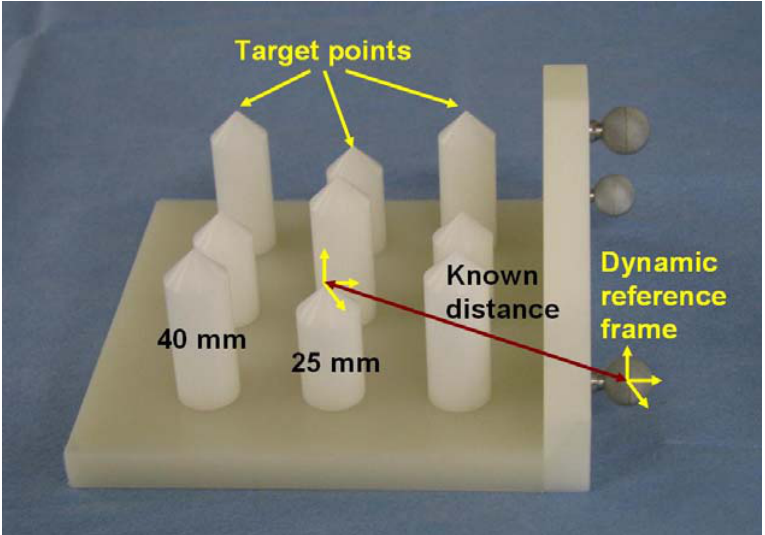
Figure 16. Accuracy testing device. The rod’s tip position in relation to the attached DRF was known in